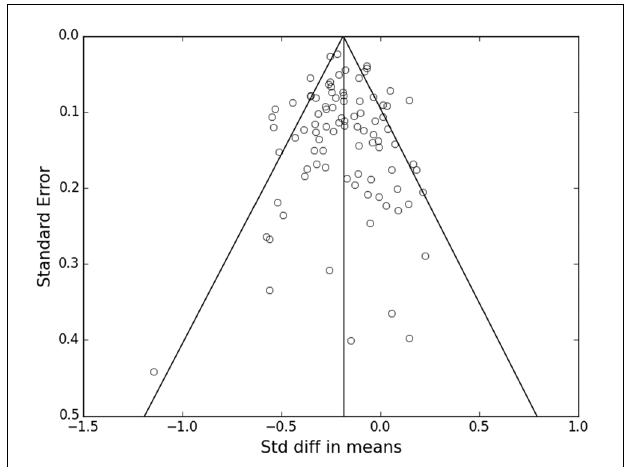
FIGURE 2 | Funnel plot of standard errors as a function of standard difference in the